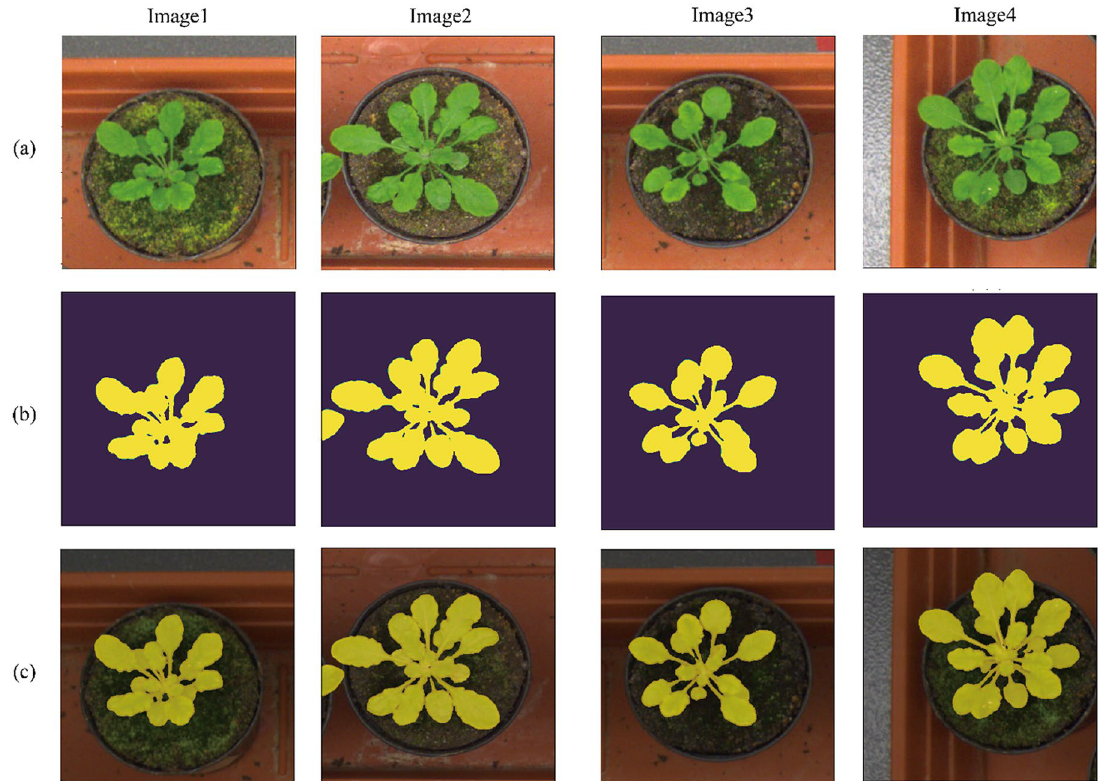
Figure 13. Qualitative results on CVPPP dataset. ( a ) input image, ( b ) output of the proposed method, and ( c ) the overlay